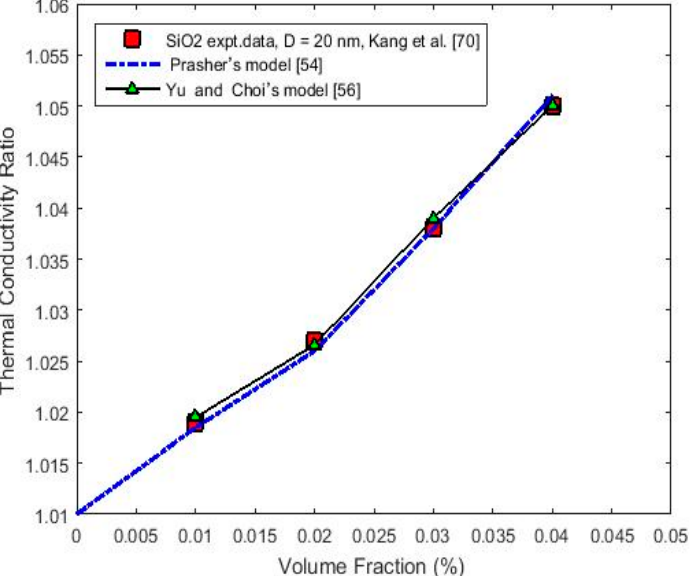
Figure 3. (Color online) Calculated thermal conductivity ratio (K ceff /K m ) versus the nanoparticle volume fraction fora SiO 2 –water NF using Prasher’s (Equation (1)) and Yu and Choi’s (Equation (6)) models. Experimental data are from [70].